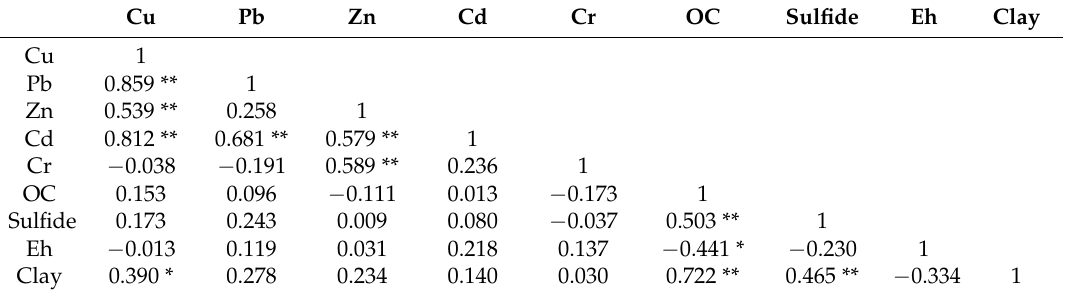
Table 4. Pearson correlation matrix for the metal concentrations and sediment properties.